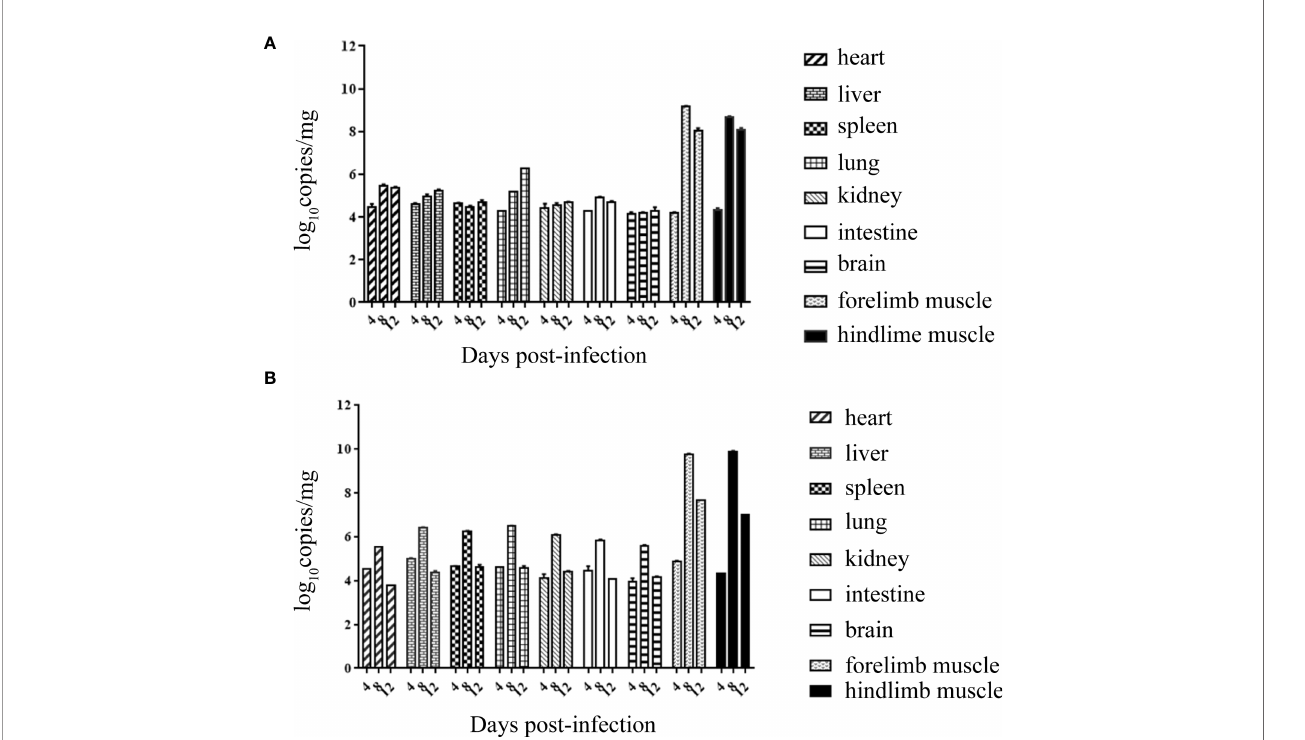
FIGURE 6 | Viral loads of all tissues of suckling mice on the 4th, 8th and 12th dpi with the RYN-A1205 (A) and KYN-A1205 (B)